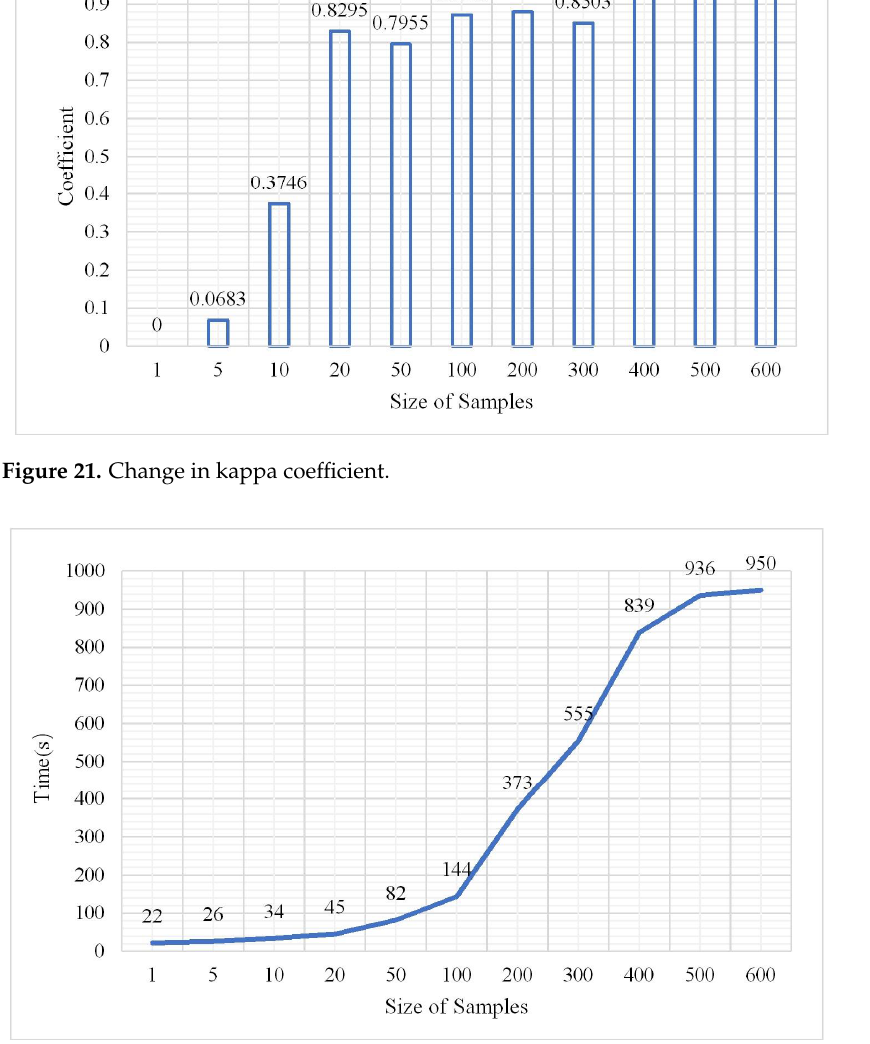
Figure 22. Change in training time.